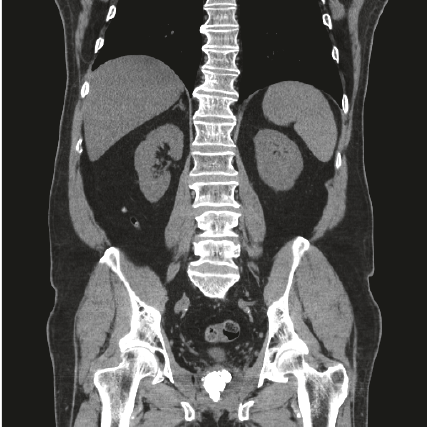
Figure 1: Coronal view of CT abdomen and pelvis noting a large burden of prostate